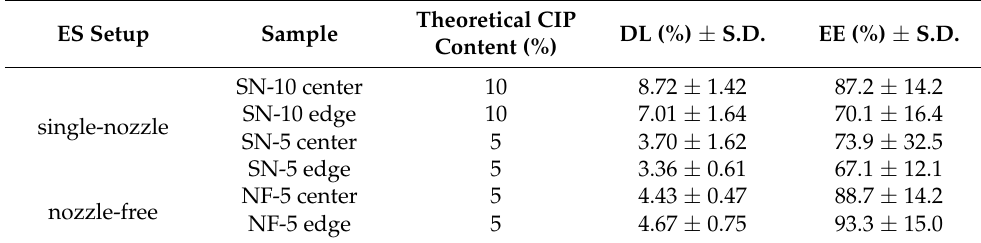
Figure 5. Raman chemical maps of nanofiber mats indicating the distribution of ciprofloxacin in the samples. Raman maps were captured on specimens collected from the center and edge of the collector. The drug distributions of the nanofiber mats were more homogeneous for nozzle-free electrospinning than for the method using a nozzle. Table 4. Drug-loading (DL) and entrapment efficiency (EE) of different formulations from the centers and the edges of the nanofiber mats. Abbreviations: ES—electrospinning, CIP—ciprofloxacin, S.D.—standard